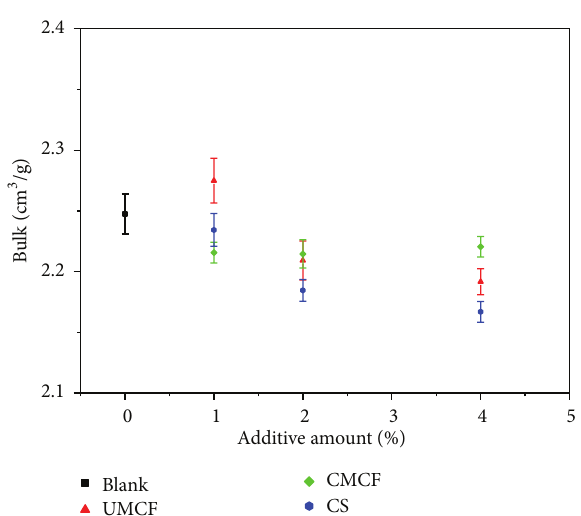
Figure 6: Bulk of paper sheets with various additive amounts of three additives (UMCF, CMCF, and CS).